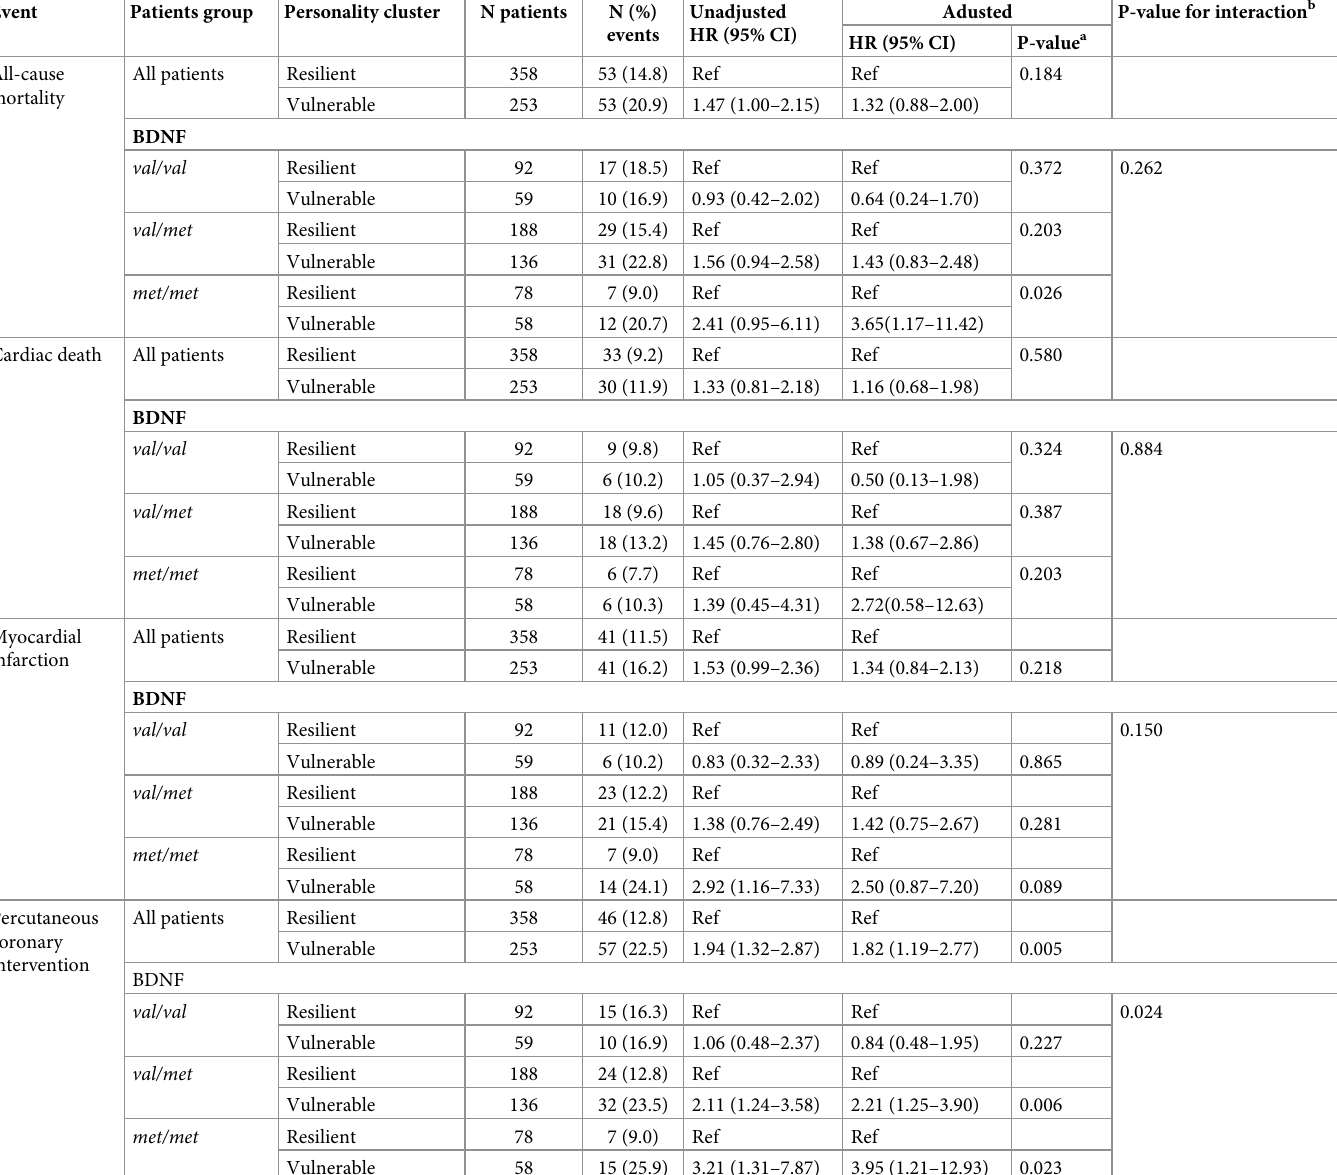
Table 2. Effect of personality cluster on cumulative incidence (%) of individual cardiac outcomes by brain derived neurotrophic factor (BDNF) val66met